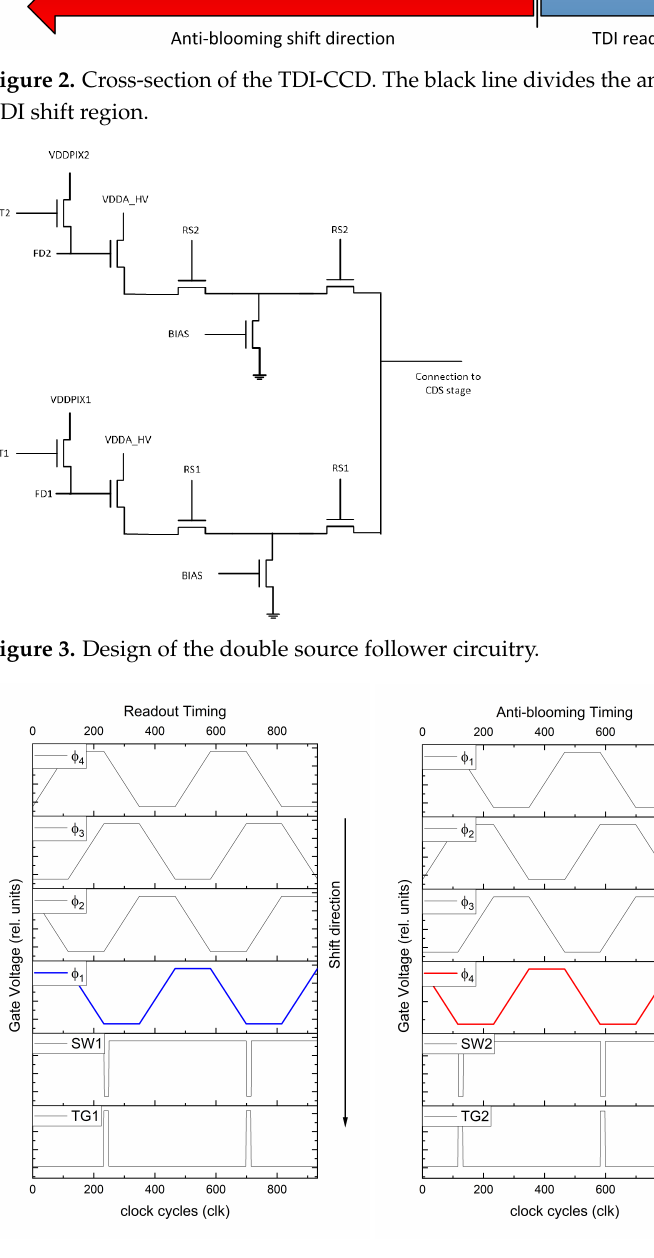
Figure 4. Timing scheme for TDI readout mode ( left ) and for anti-blooming mode ( right